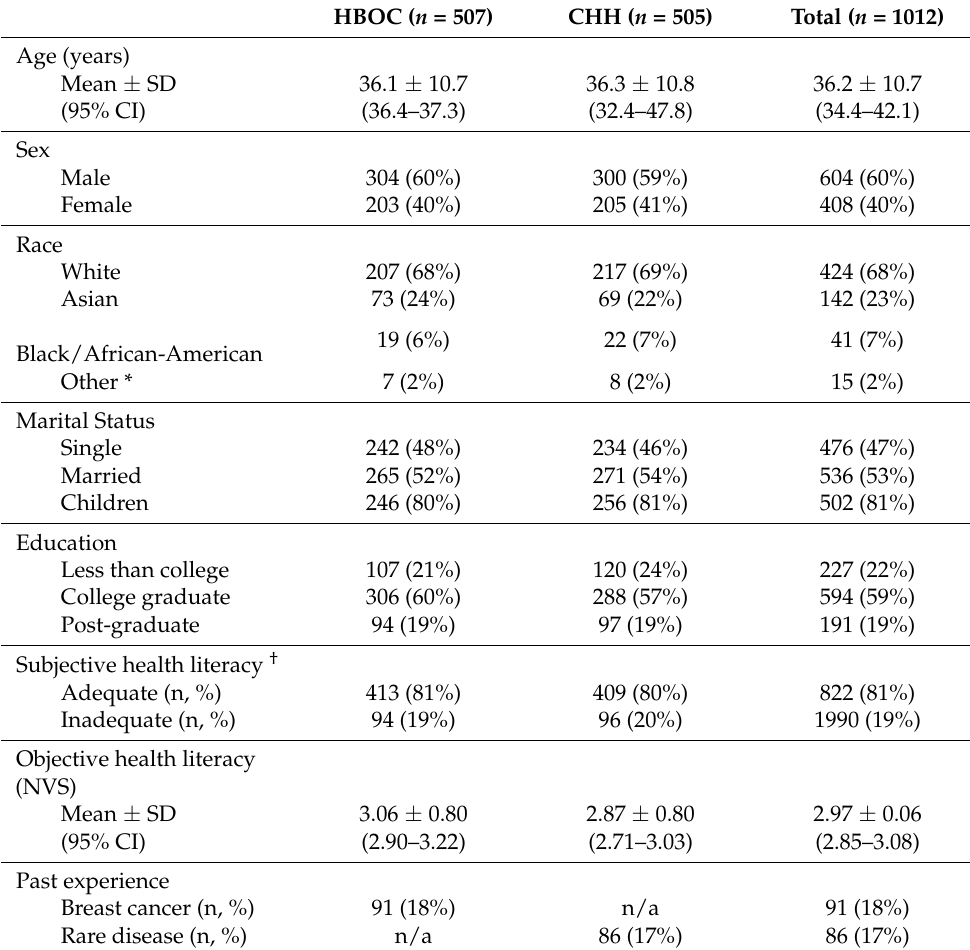
Table 1. Participant sociodemographics ( n =